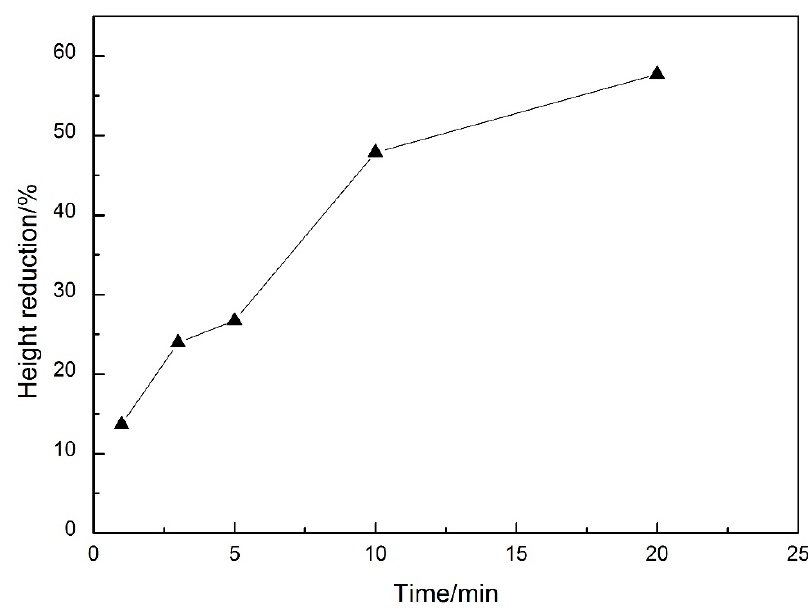
Figure 5. Height reductions in the bonded Ti–5Al–2Sn–2Zr–4Mo–4Cr alloy at different times.